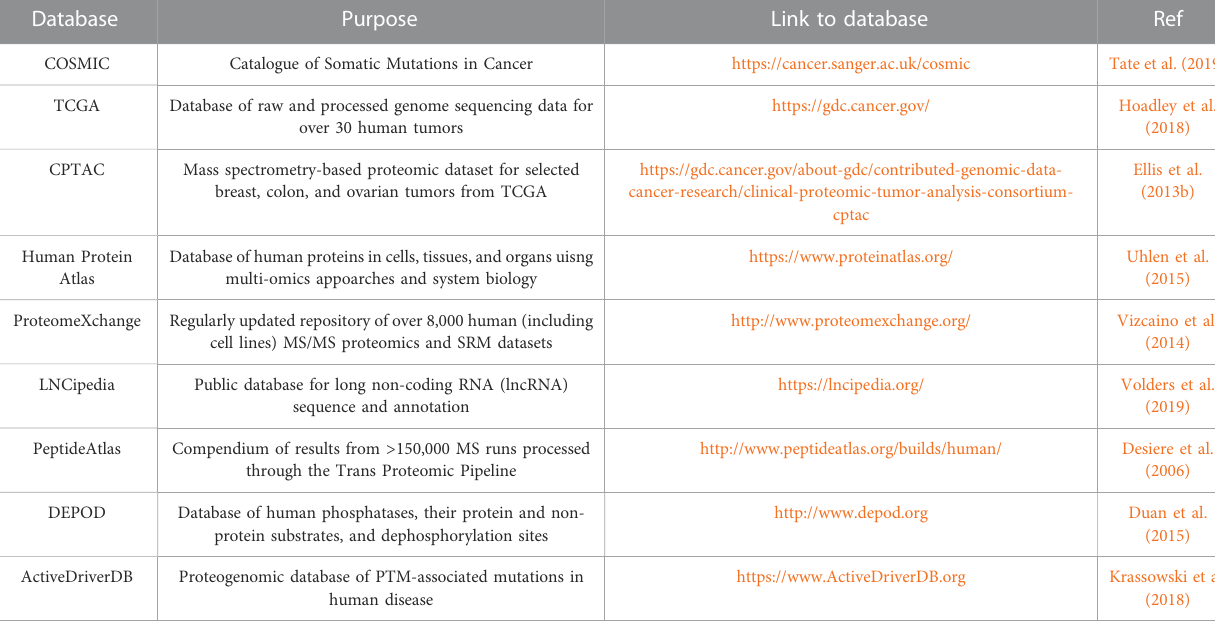
align select or all MS2 transitions and retention times of in vivo peptides and their “ heavy isotope ” synthetic counterparts that serve as internal standards. Typically, a list of m/z ratio of the precursor